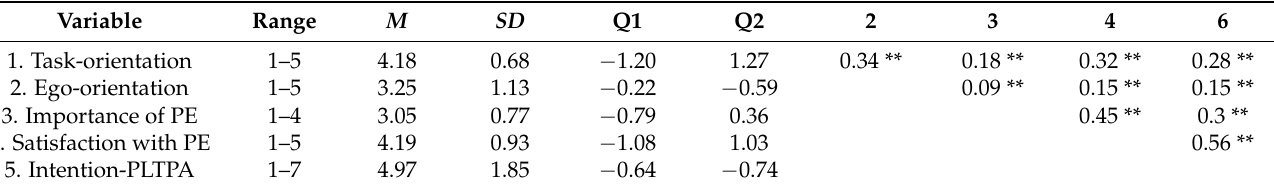
Table 1. Descriptive statistics and correlation between